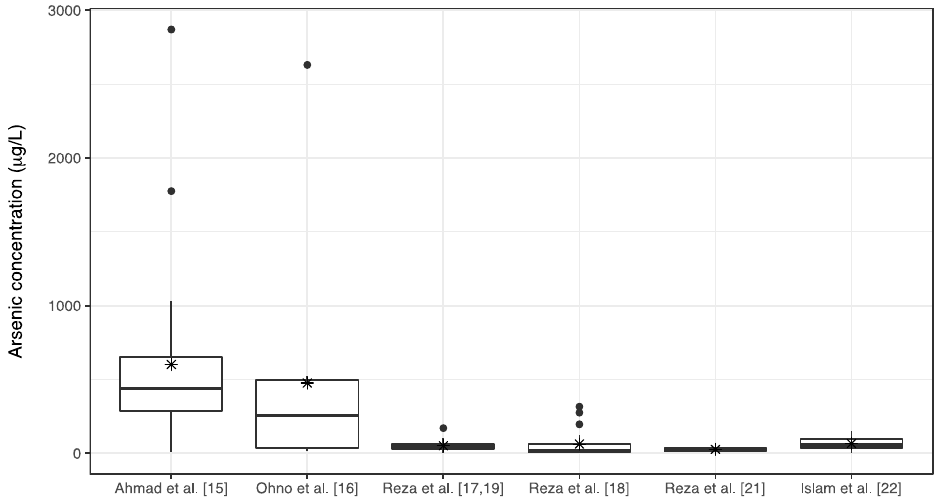
Figure 2. Boxplots of As concentrations from previous scientific literature data. The boxplots show the “minimum”, first quartile (Q1), median, third quartile (Q3), and “maximum” values where the maximum value is determined by Q3 + 1.5 × (Q3 − Q1) and the minimum values is determined by Q1 − 1.5 × (Q3 − Q1). Black dots and asterisks represent outliers and mean values, respectively.